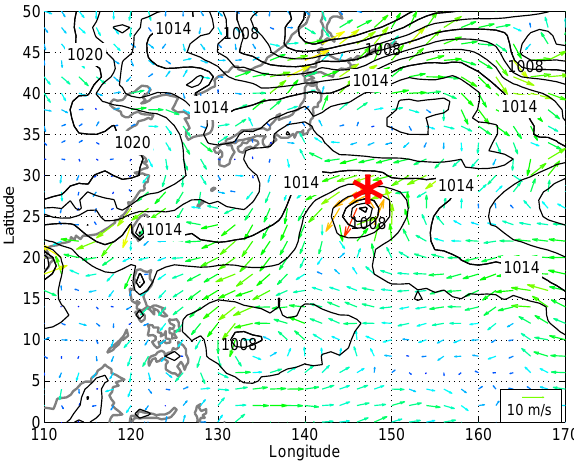
Fig. 4. Sea level pressure (hPa) and wind arrows (ms − 1 ) for the storm Nepartak on 12 October 2009 at 12:00UTC, using opECMWF analysis. The location of R/V Sonne is displayed by the red star. The contour intervals are